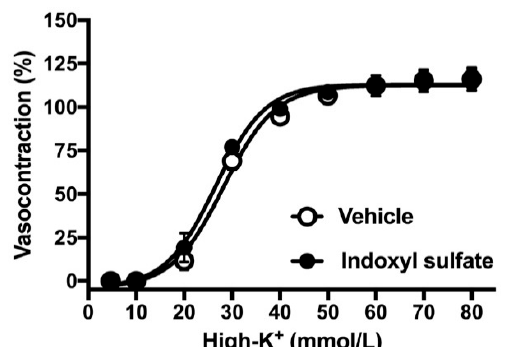
Figure 3. Concentration–response curves for high K + -induced vasocontractions in the aortas in the absence (vehicle) and presence of indoxyl sulfate (10 − 4 mol/L). The ordinate shows vasocontraction as a percentage of 80 mmol/L high-K + -induced vasocontraction. Data are presented as mean ± standard error of mean (SEM) values from eight experiments.